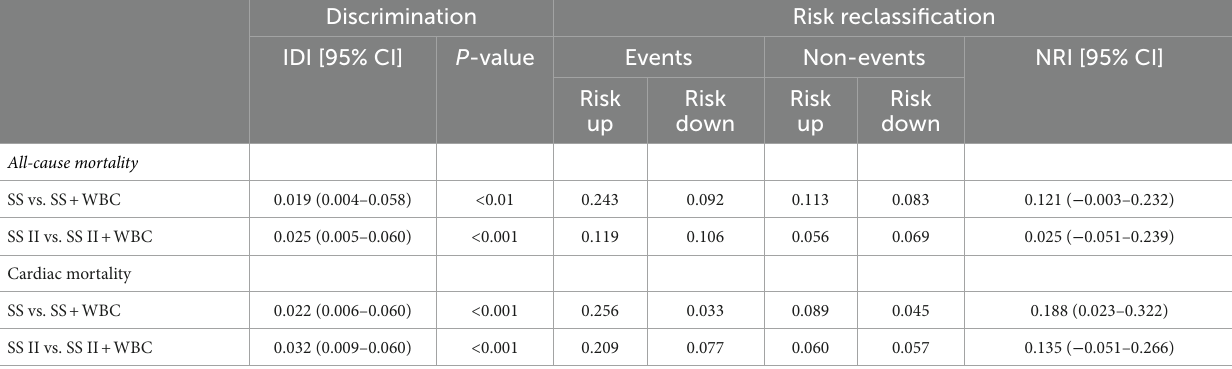
TABLE 5 Statistics for model improvement of for all-cause mortality and cardiac